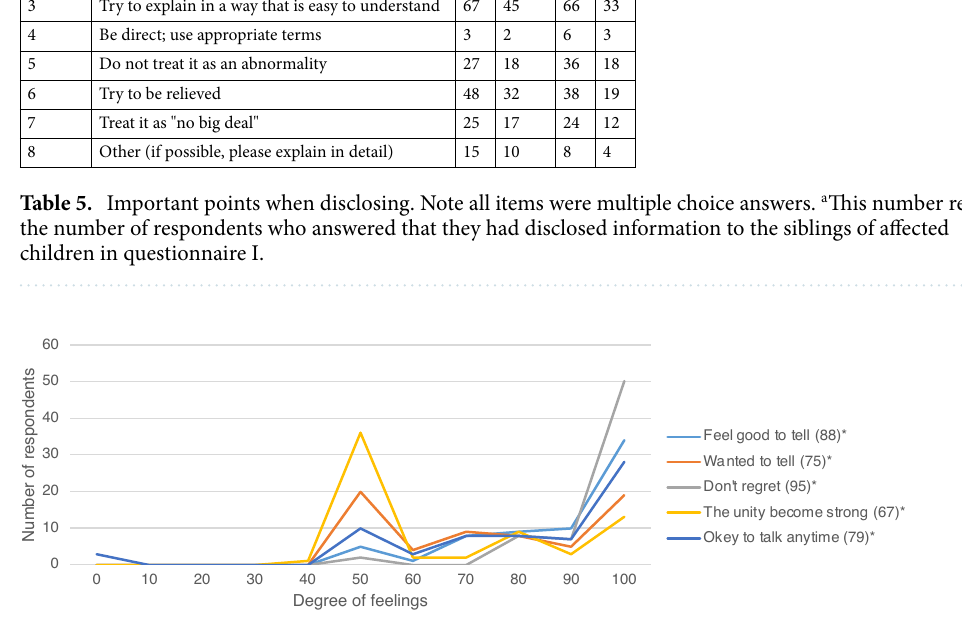
Figure 3. Degree of feelings of respondents after disclosing information. Note respondents chose any number on a scale between 0 (lowest) and 100 (highest) as indicating the degree of their feelings. *Mean values for each